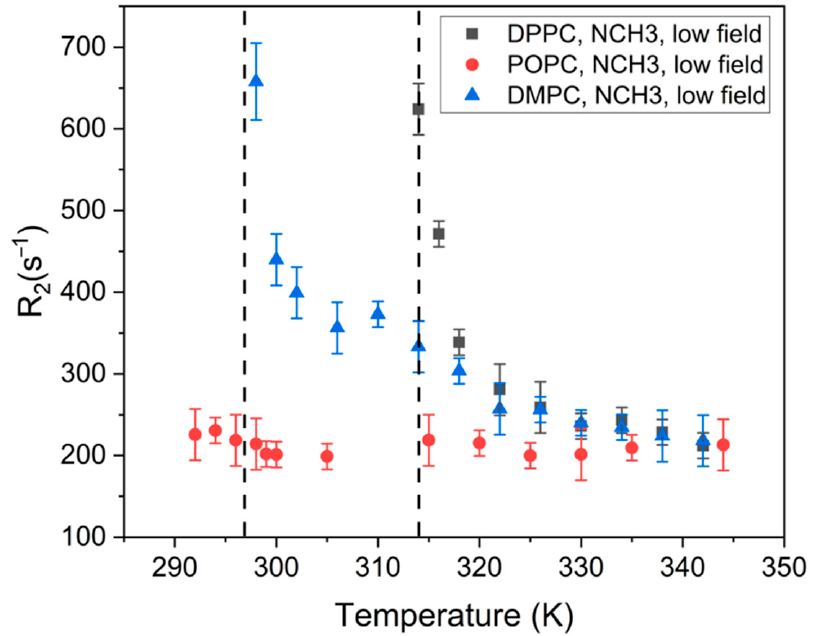
Figure 3. The dependence of the relaxation rate ( R 2 ) of the low-field components of the signal of N + (CH 3 ) 3 groups on the temperature.